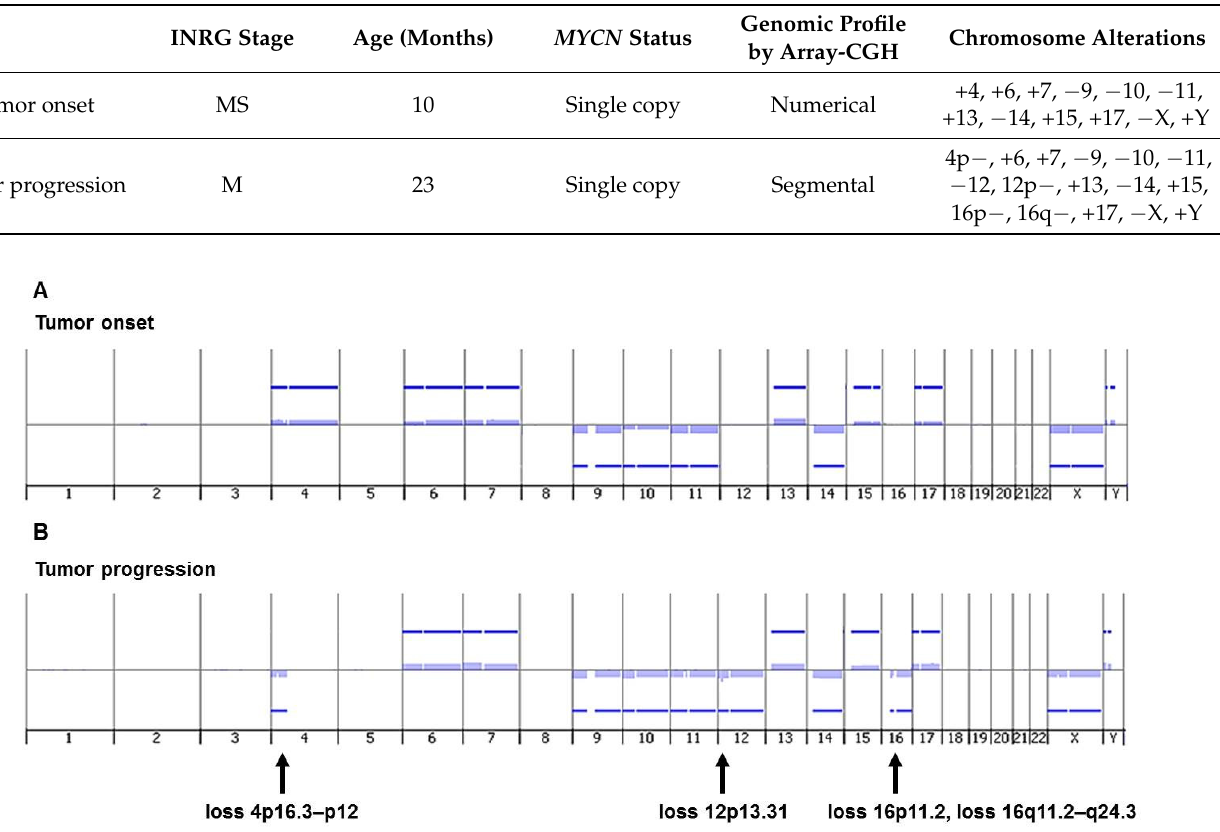
Table 1. Patient’s characteristics and tumor DNA genomic profile analysis.